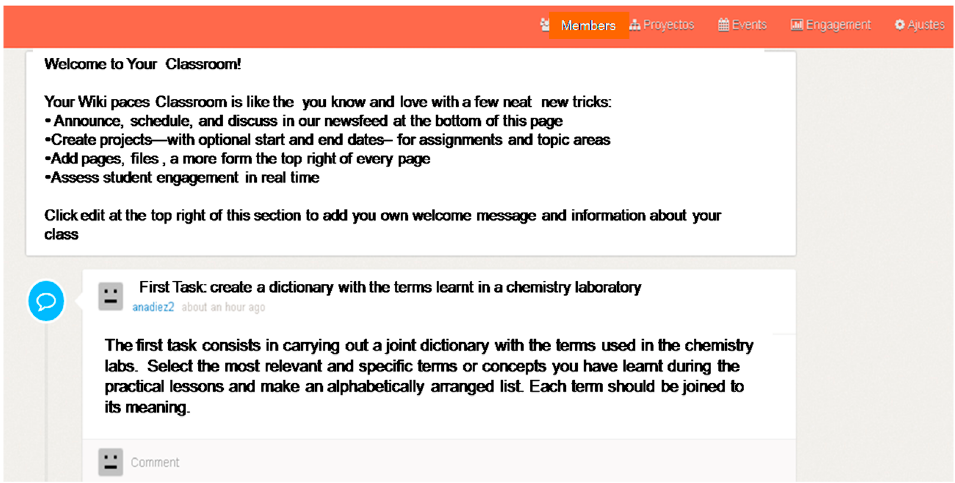
Figure 2. First page of the wiki activity developed for the students.